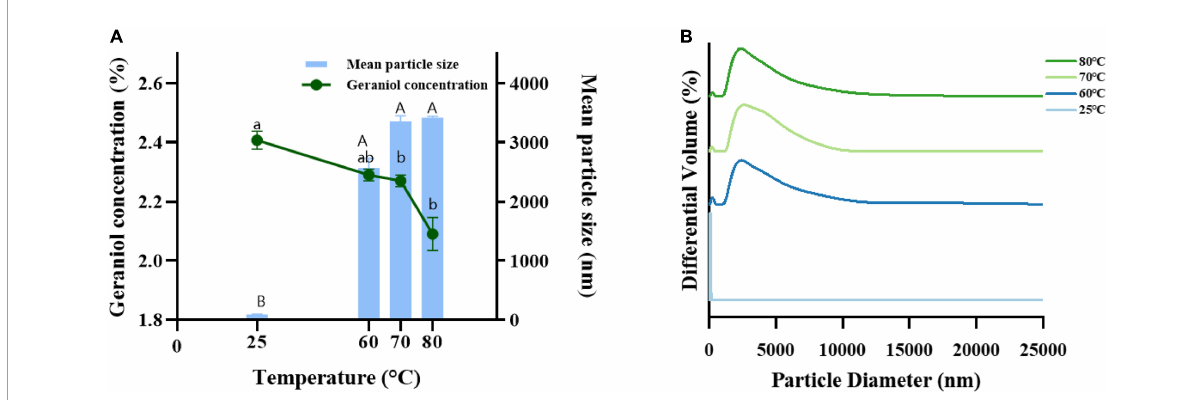
FIGURE6 Effect of heating to 60 ◦ C, 70 ◦ C, and 80 ◦ C on the mean particle size (A) , geraniol content (A) and particle size distribution (B) of G-NE. (Different capital (lowercase) letters indicate significant intra-group variability, p < 0.05 ; identical capital (lowercase) letters indicate significant inter-group variability, p > 0.05 ).